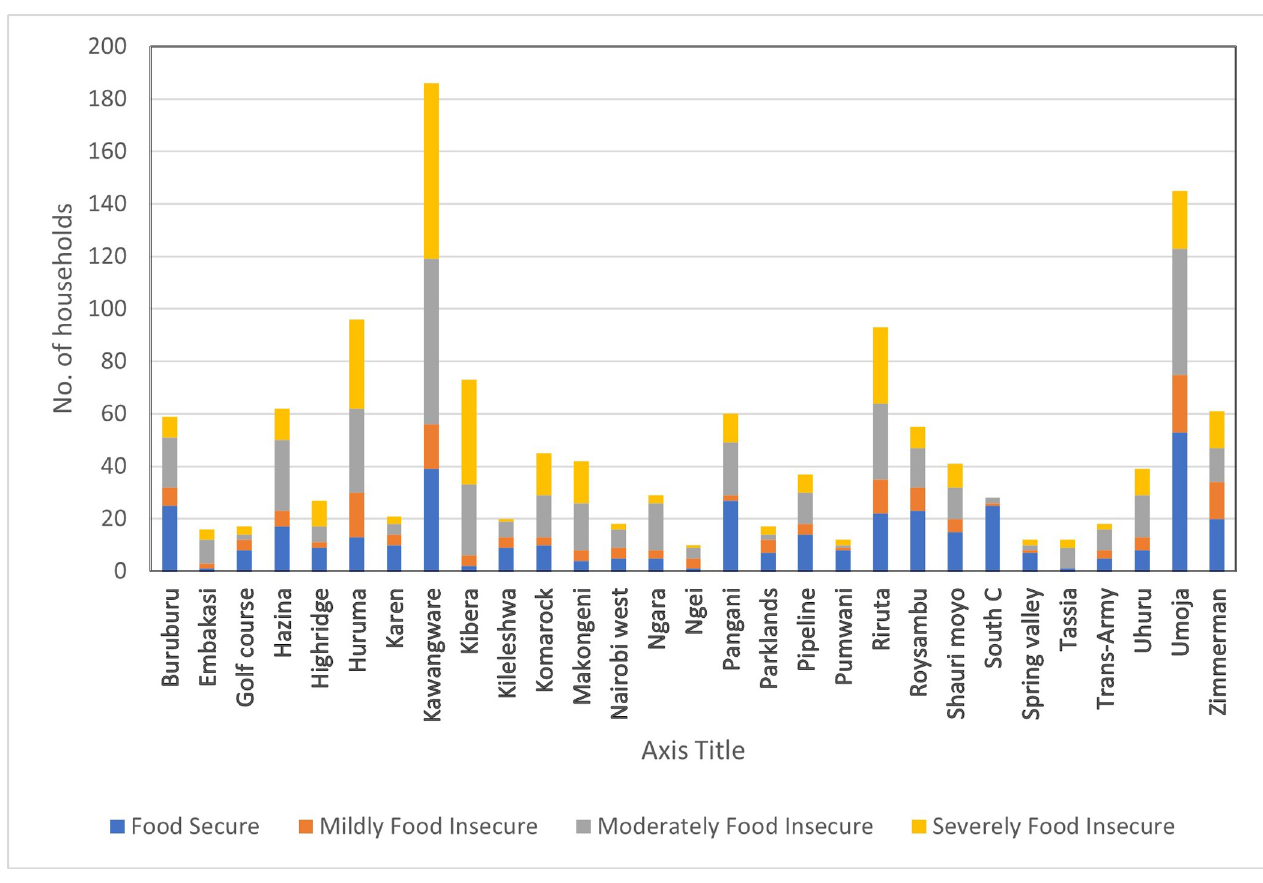
Fig 1. Household food security by Nairobi